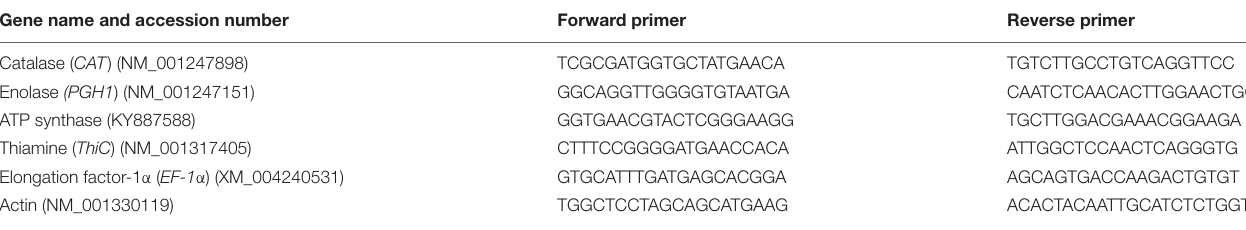
TABLE 1 | Details of primers used in the qRT-PCR